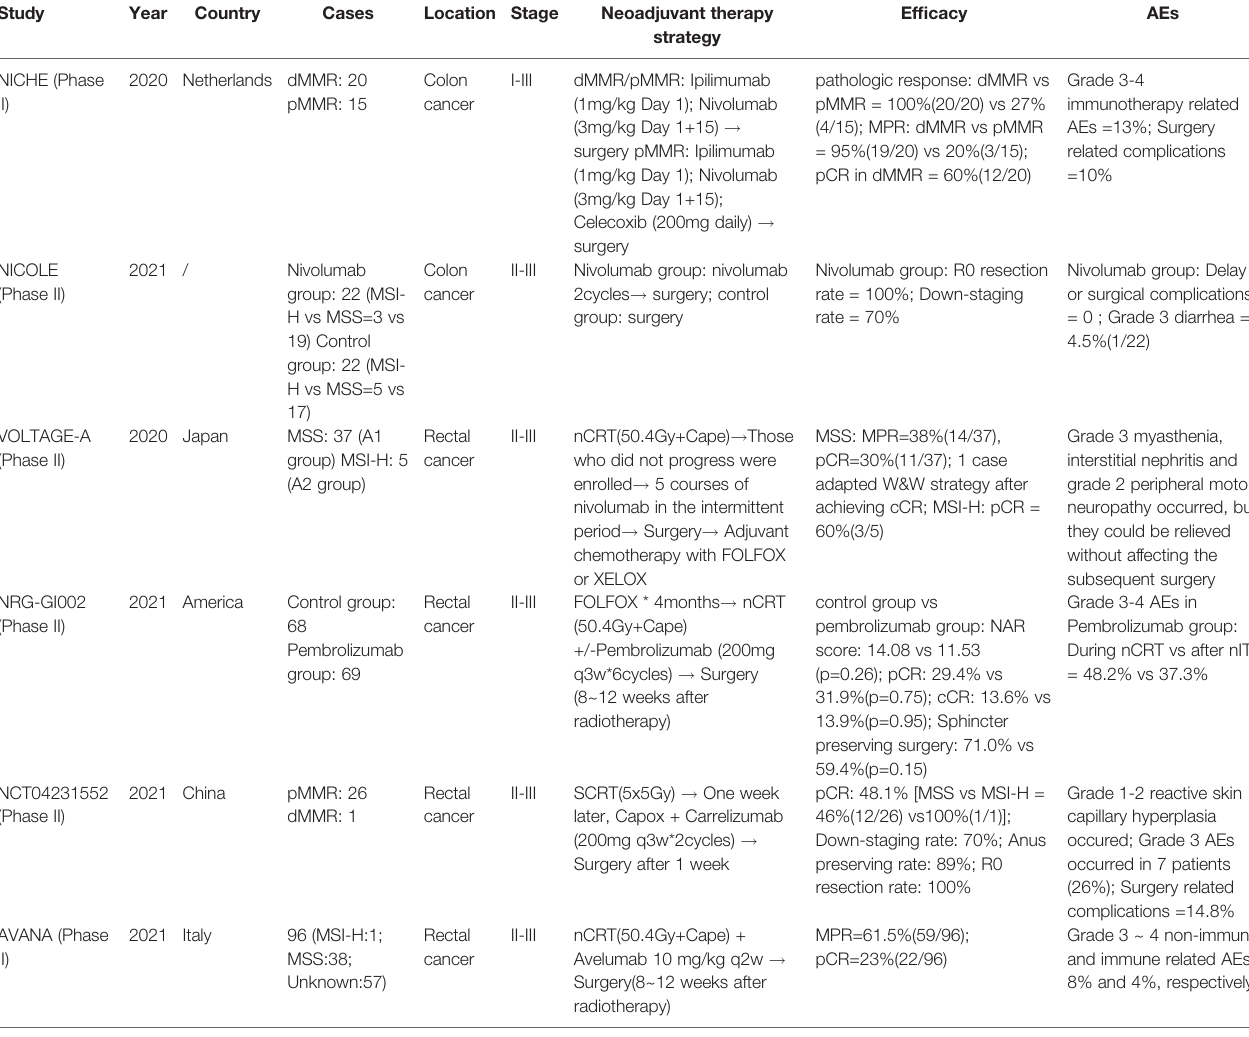
TABLE 1 | Prospective clinical trials of nIT for MSI-H/dMMR non-mCRC.